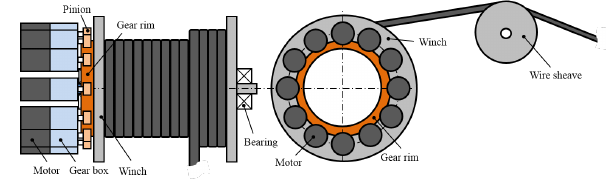
Figure 1: Simple sketch of a winch system.